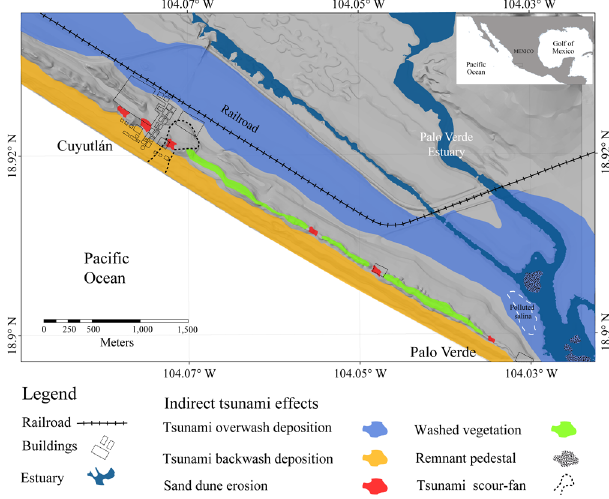
Fig. 10. Indirect tsunami effects